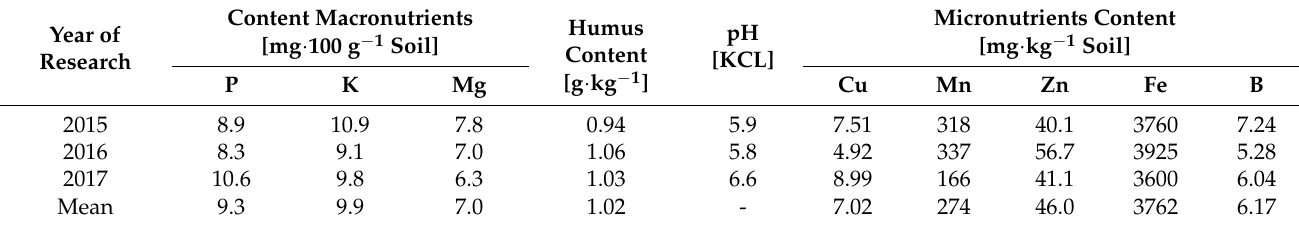
Table 1. Physicochemical characteristics of the soil before establishing the experiment in 2015–2017. Year